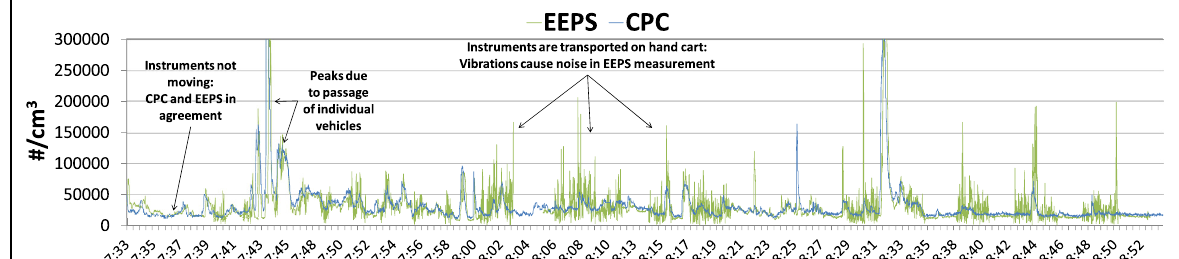
Figure 4. Comparison of particle number concentrations measured by CPC and EEPS; EEPS noise due to handcart vibration during its movement to another measurement stop and measurement stops are indicated on 30 January, EEPS and CPC are in agreement in total particle